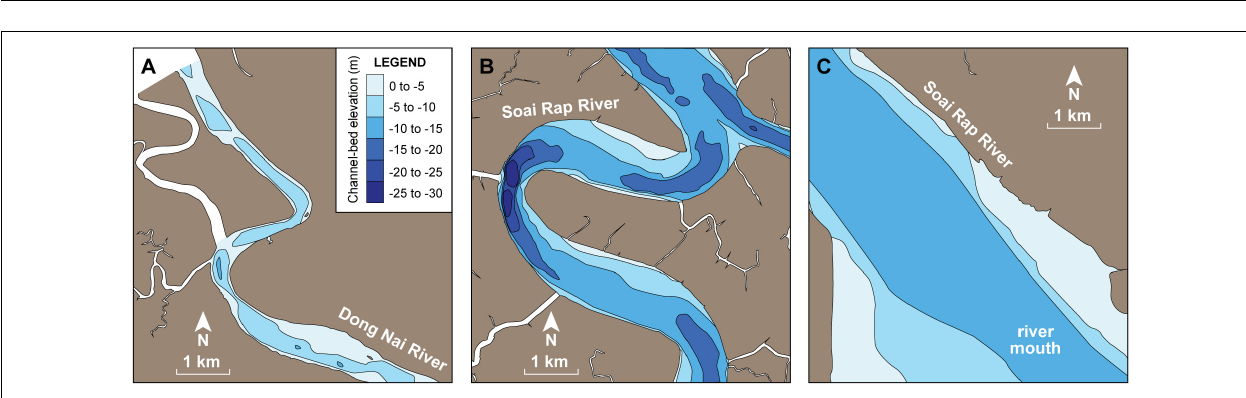
FIGURE 6 | Bathymetric maps of selected parts of the Ð`ông Nai–Soài Ra.p River (modified from United States Army maps, Corps of Engineers, 1965). (A) Upstream part. (B) Intermediate part. (C) River-mouth area. See Figure 1C for